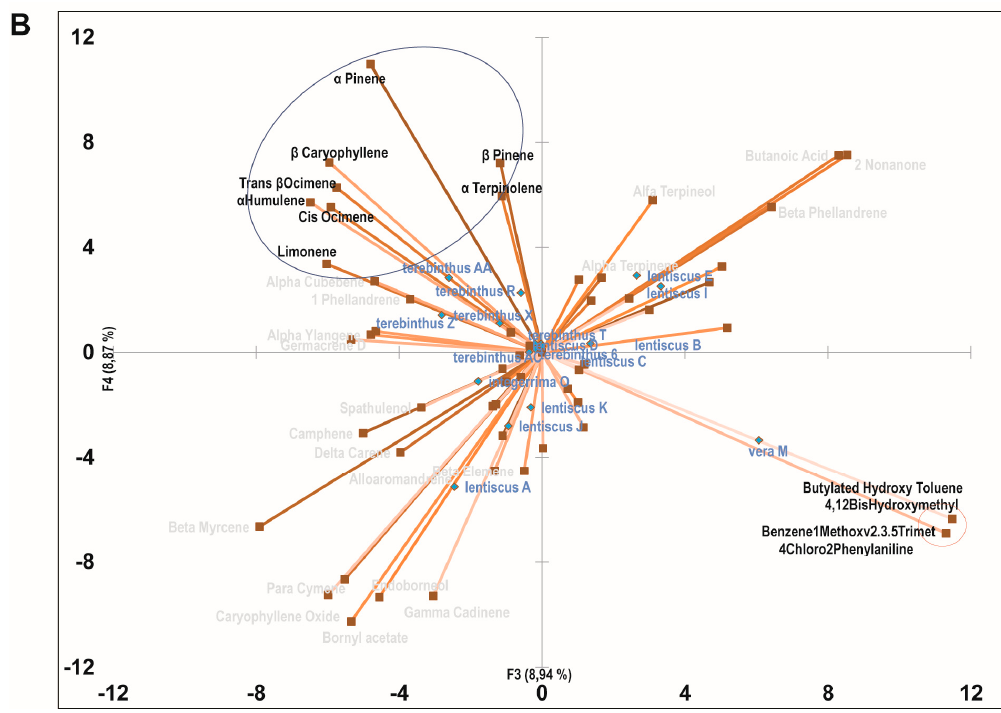
Figure 3. Principal component analysis of the cytotoxic effect of Pistacia essential oils on MCF-7 cells. ( A ) PCA biplot with PC1 and PC2 distribution of essential oil samples and chemical components of the phytocomplexes. ( B ) PCA biplot with PC3 and PC4 distribution of essential oil samples and chemical components of the phytocomplexes. Clusters of cooperating compounds with a positive correlation to one or two components are identified with circles (green for P. lentiscus , yellow for P. integerrima , blue for P. terebinthus , and red for P. vera ).